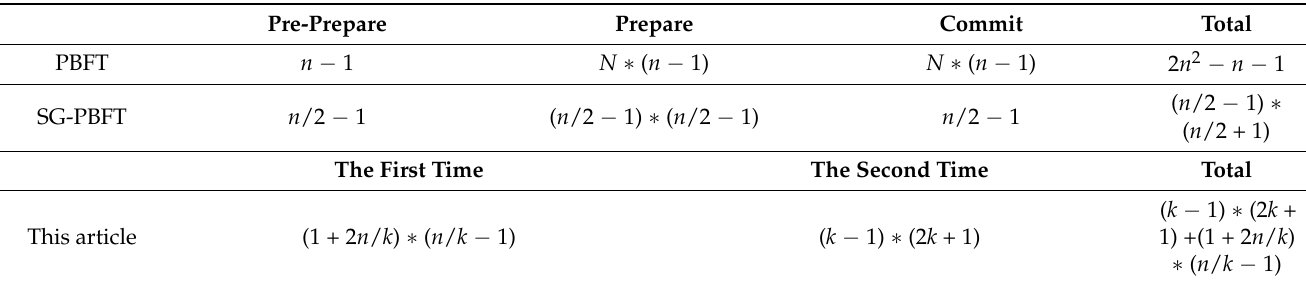
Table 2. Comparison of Communication Complexity.